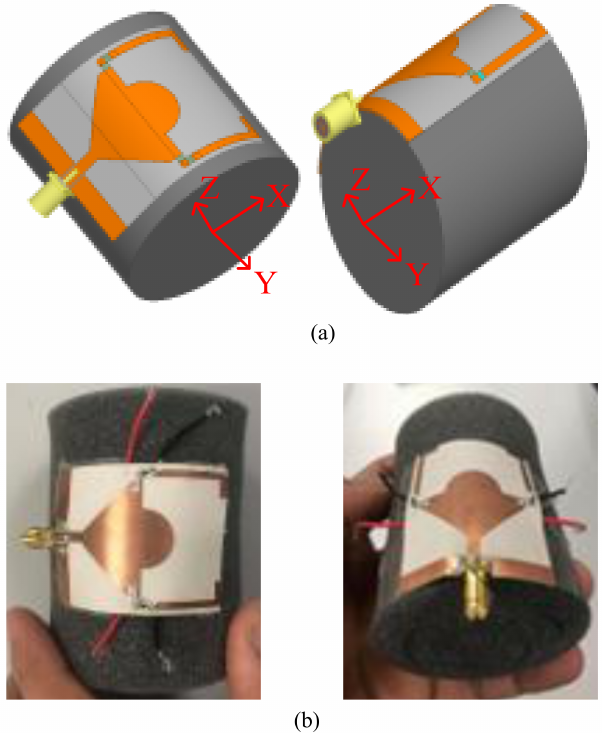
Figure 9. System of the structure used for conformability analysis: ( a ) Simulation setup and ( b ) mea- surement